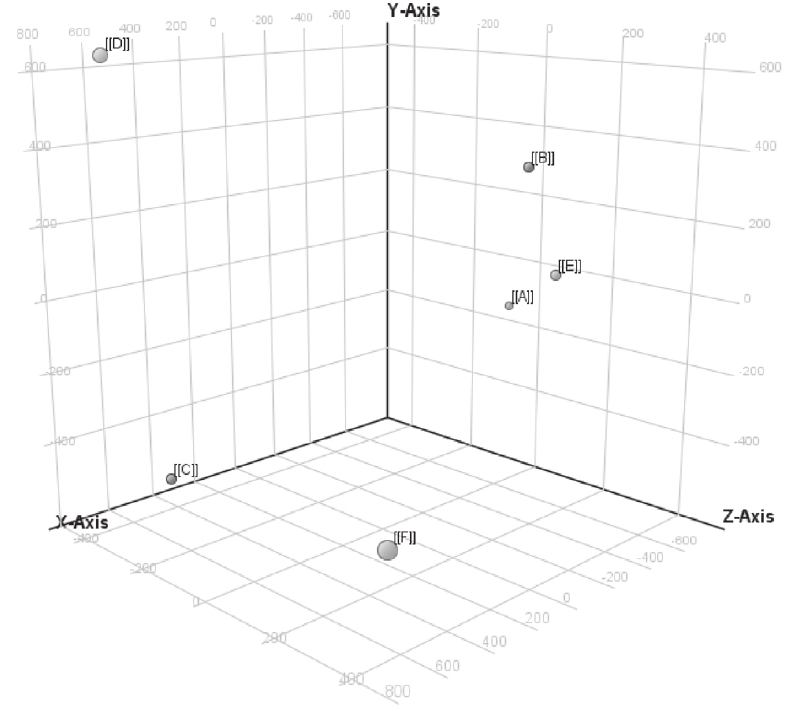
Figure 3: Comparison of the sample preparation methods by PCA.